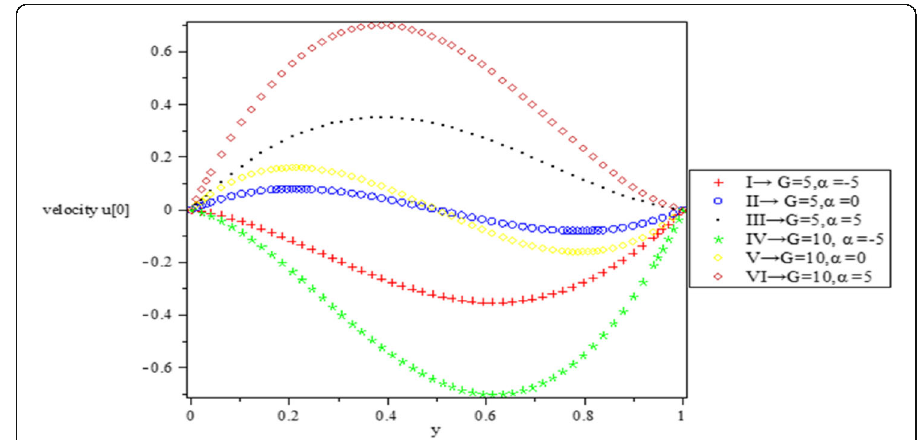
Fig. 2 Zeroth-order velocity (u[0] profile, r = − 1 and β =